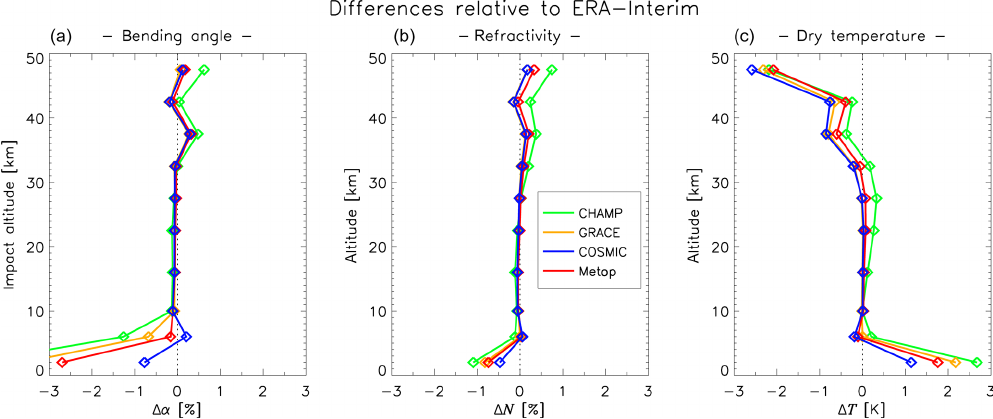
Figure 6. Globally averaged monthly mean bending angle (a) , refractivity (b) , and dry temperature (c) differences relative to ERA-Interim, for the four RO missions included in the ROM SAF CDR. The profiles show time averages, with the averaging period chosen as the full length of the respective satellite